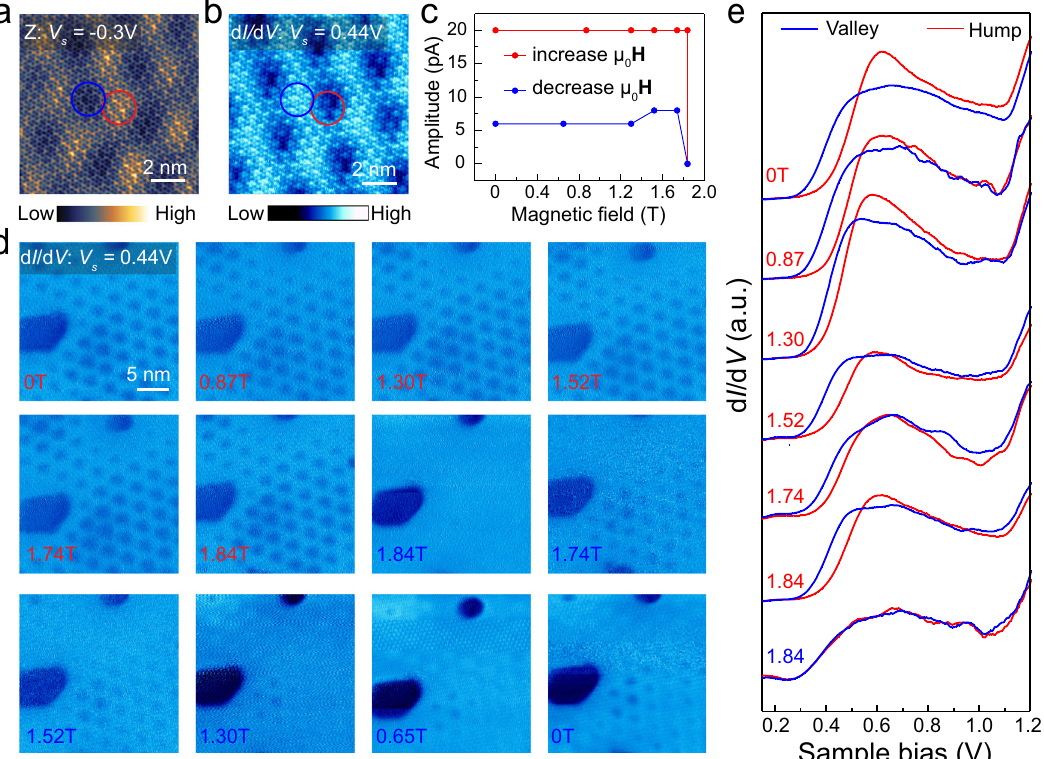
Fig. 4 Magnetic fi eld-dependent moiré contrast in dI / dV maps. a STM image ( V s = − 0.3V, I t = 0.2 nA) shows the moiré pattern of G/FL-CrI 3 /Gr. The lower (higher) region is referred as moiré valley (hump) indicated by the blue (red) circle. b The corresponding d I /d V map ( V s = 0.44V, I t = 0.5nA). c Magnetic fi eld-dependent moiré contrast in the d I /d V maps ( V s = 0.44V, I t = 0.5 nA). d Magnetic fi eld-dependent d I /d V maps ( V s = 0.44V, I t = 0.5 nA). e Magnetic fi eld-dependent d I /d V spectra taken at moiré valley (blue) and hump